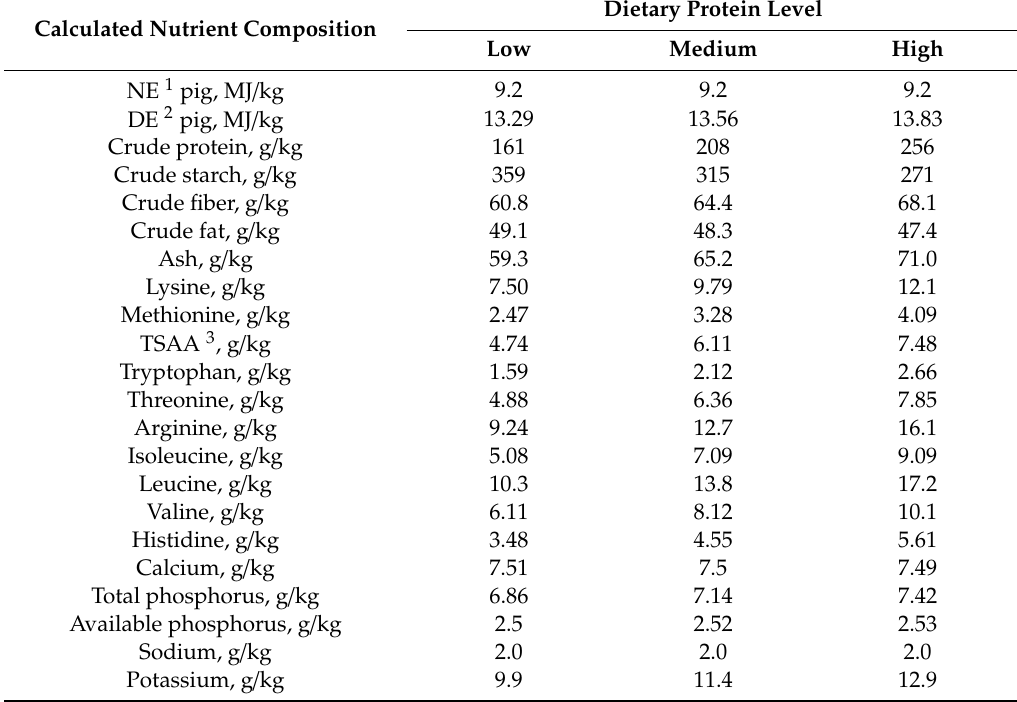
Table 2. The nutrient composition (as-is basis) of the various dietary protein finisher diets fed to immunocastrated and entire male pigs from 20 to 24 weeks of age, with or without ractopamine hydrochloride supplementation. All amino acids shown are provided as their digestible